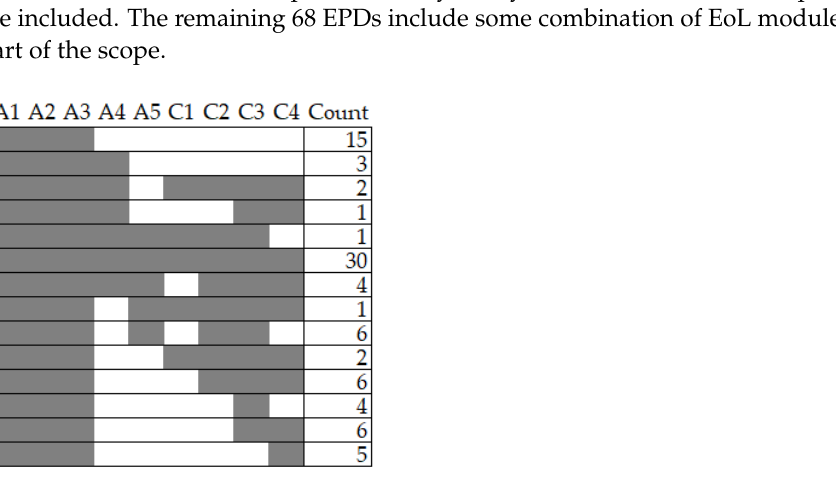
Figure 3. Number of EN 15804 EPDs and their year of approval.